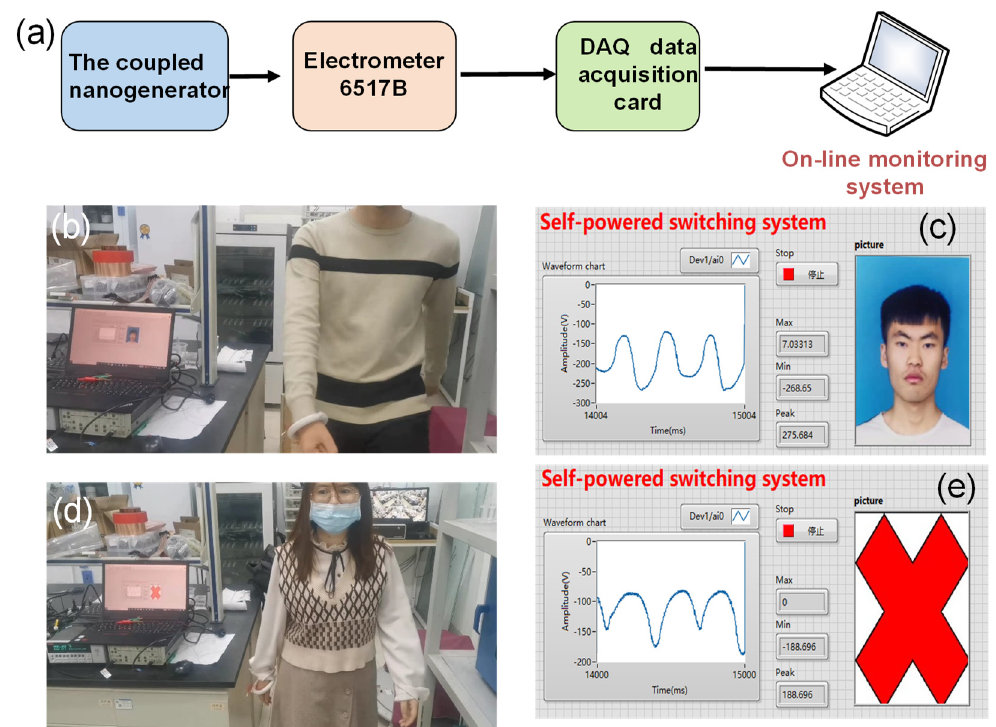
Figure 6. Self-powered switching system: ( a ) the block diagram of the self-powered switching system; ( b , c ) the demonstration results of passable personnel; and ( d , e ) the demonstration results of impassable personnel.